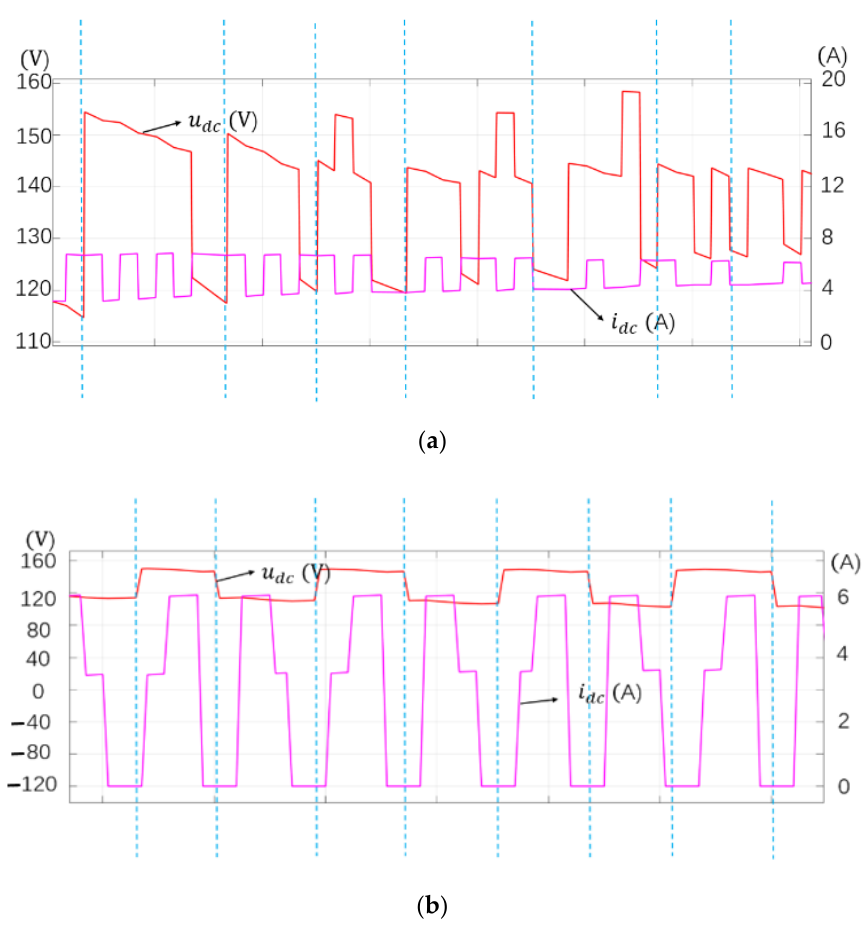
Figure 15. Waveforms of dc-link voltage 𝑢 𝑑𝑐 and current 𝑖 𝑑𝑐 : ( a ) with the CMPC; ( b ) with the VMMPC and the OSS.